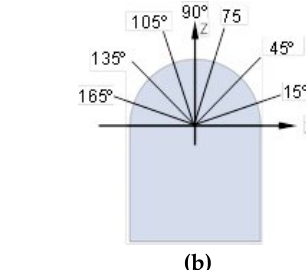
Table 2. Low and high levels for factors a e , a p , f z and v c.